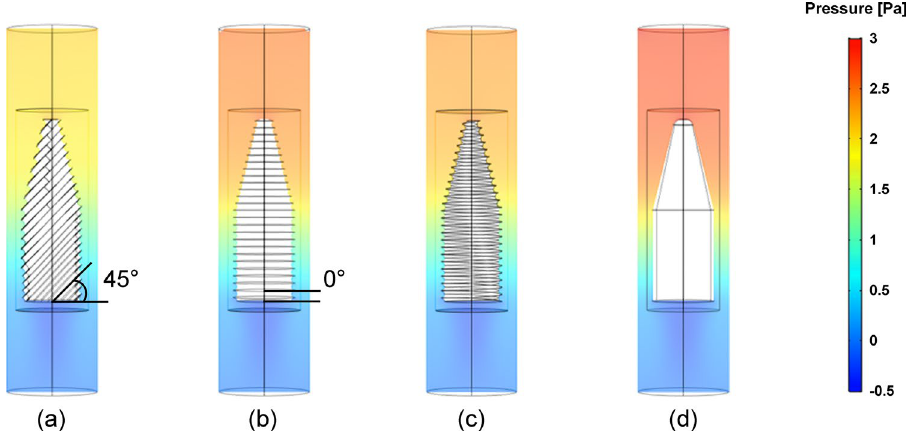
Figure 4. Simulated pressure distribution in the water stream with MDDs with ( a ) 45°-tilted blades, ( b ) 0° blades, ( c ) helical blades, and (d) without blades (plain type).